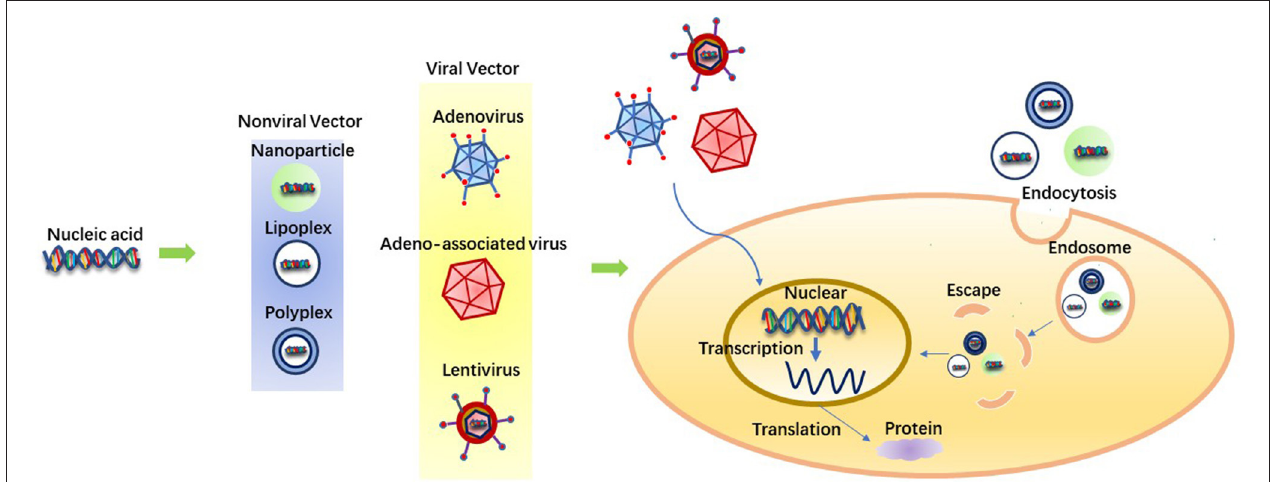
FIGURE 1 | Different vectors in gene therapy and the procedure of gene